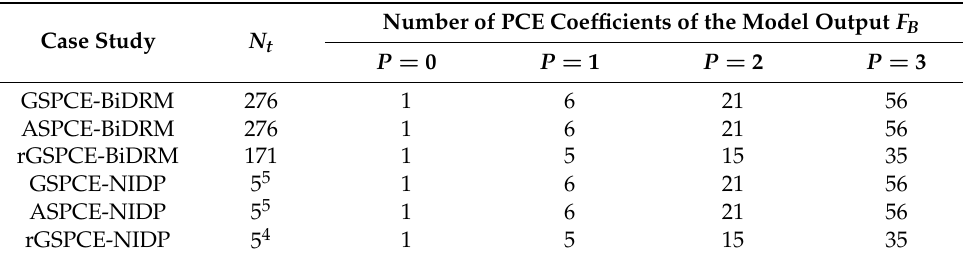
Table 6. Summary of the number of PCE coefficients and the number of evaluations in Example 2.